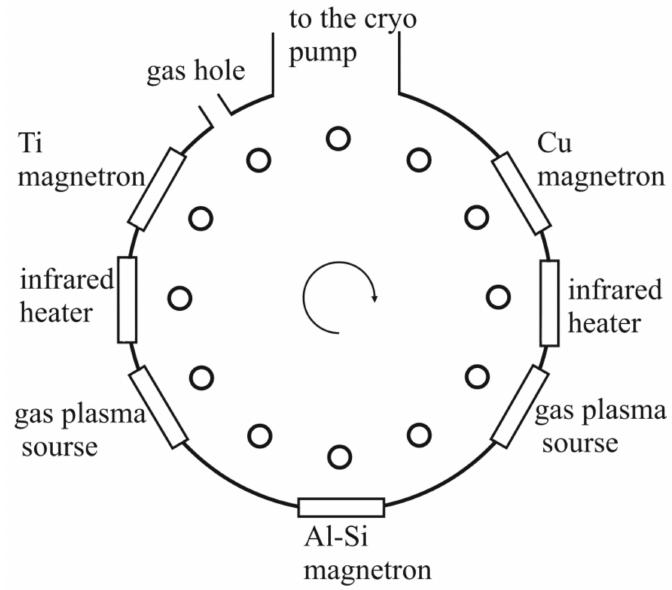
Figure 1. The scheme of the unit for the coatings